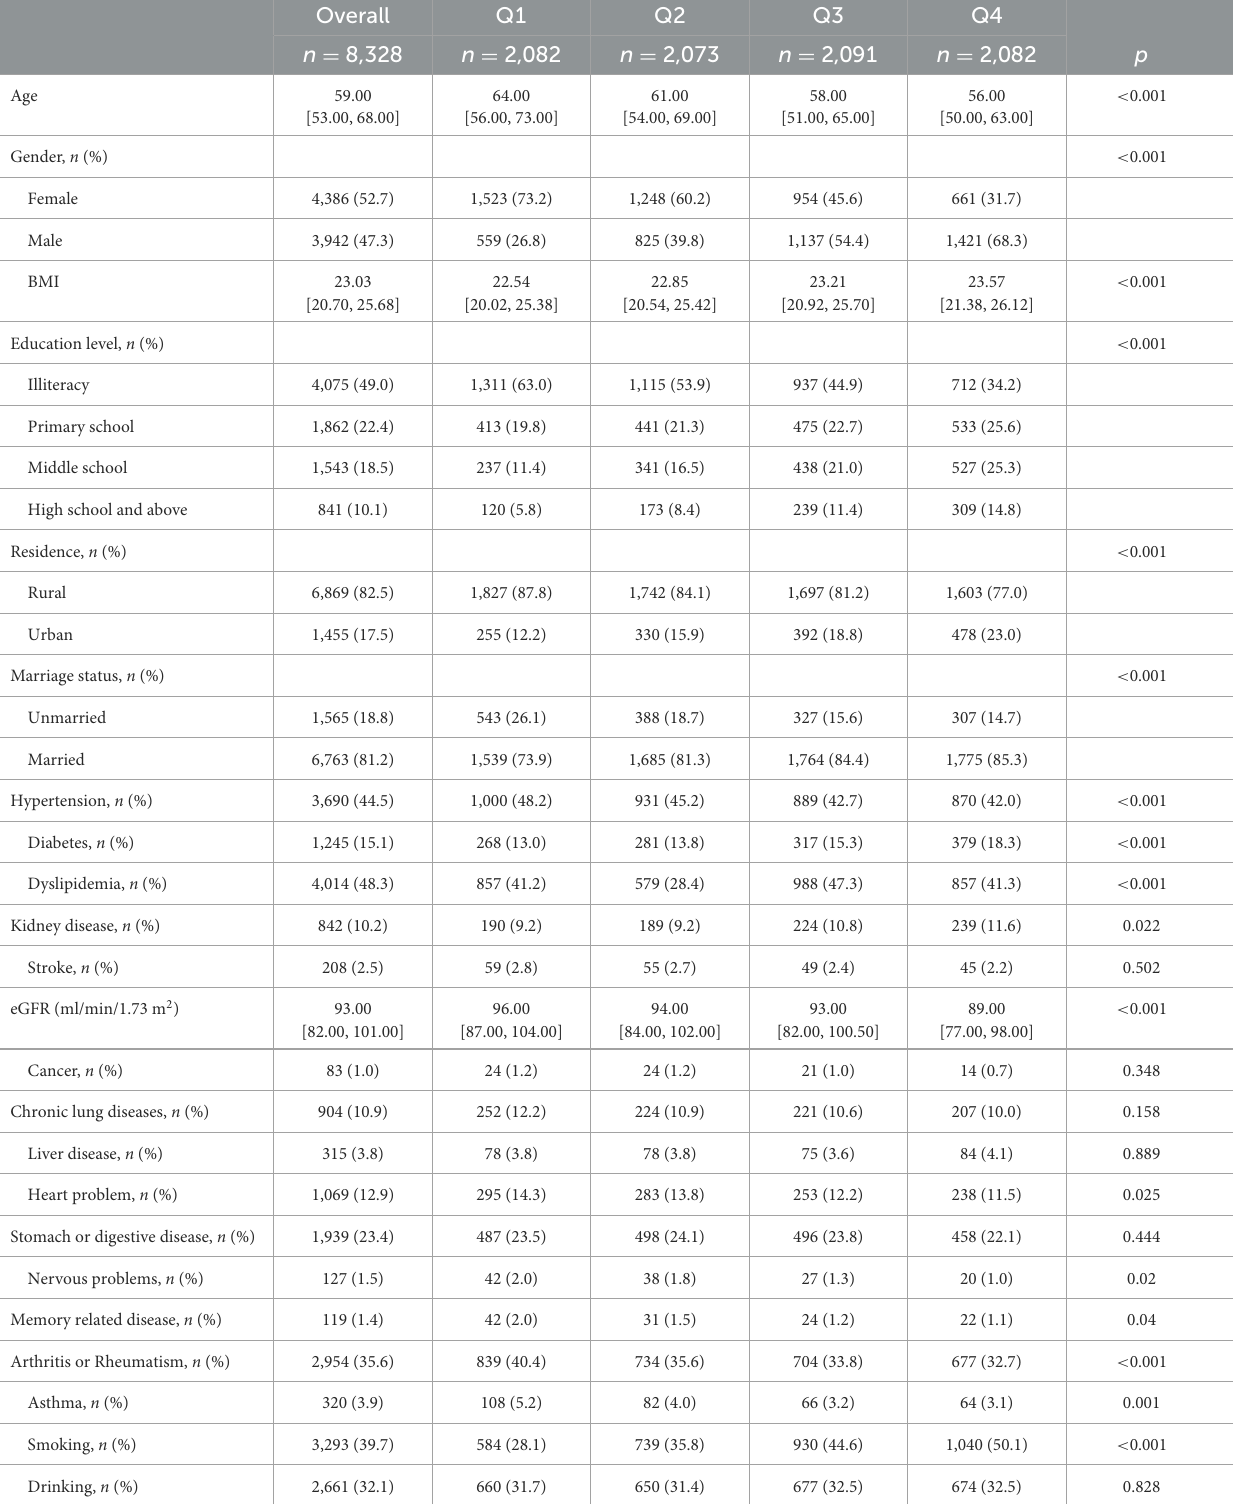
TABLE 1 Baseline characteristics of the study participants ( N = 8,328).